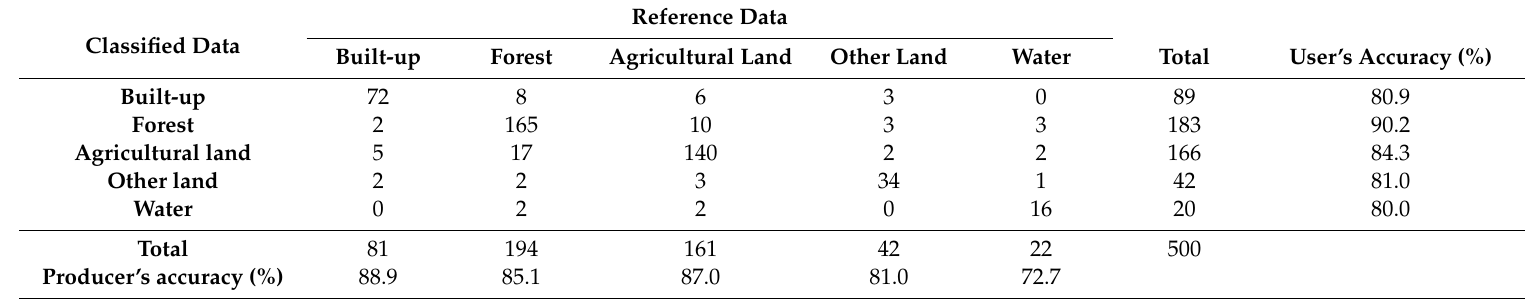
Table A1. Error matrix for the classified 1996 land use / cover map.